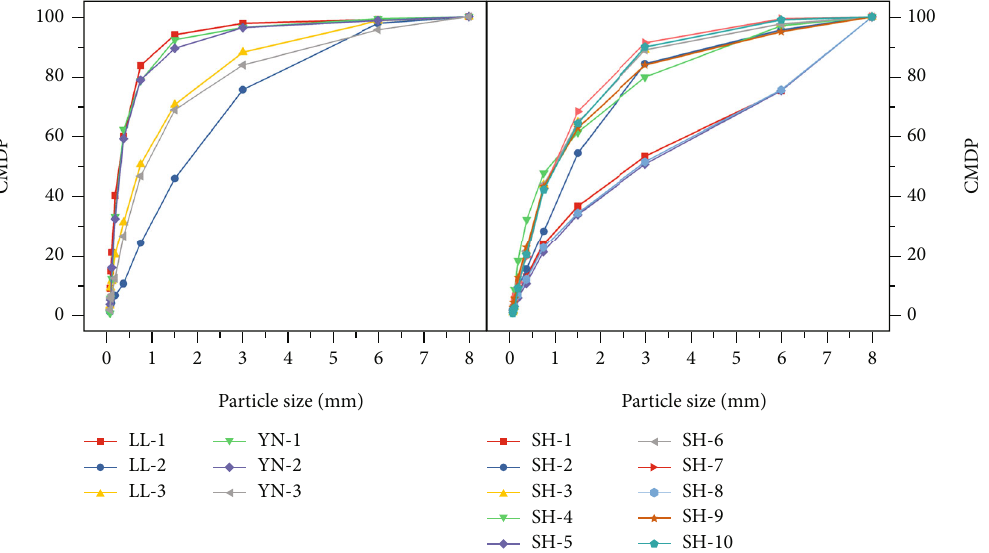
Figure 6: Curve fi tting results of cumulative mass distribution.